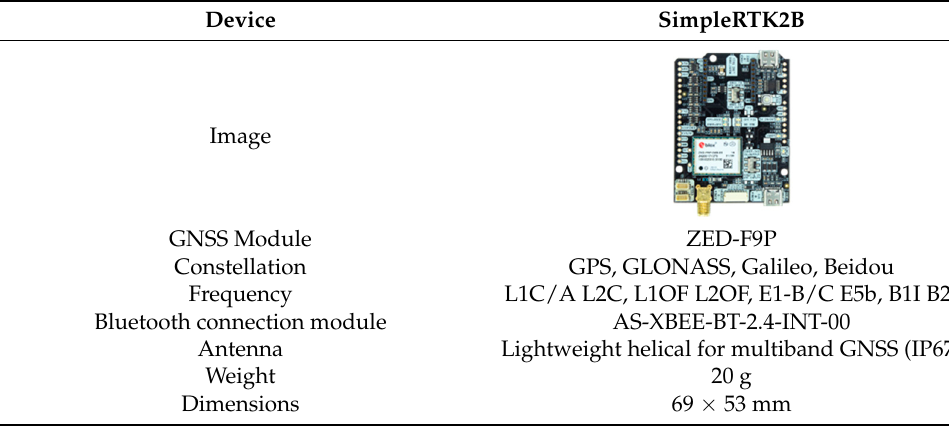
Table 2. Technical features of the SimpleRTK2B.